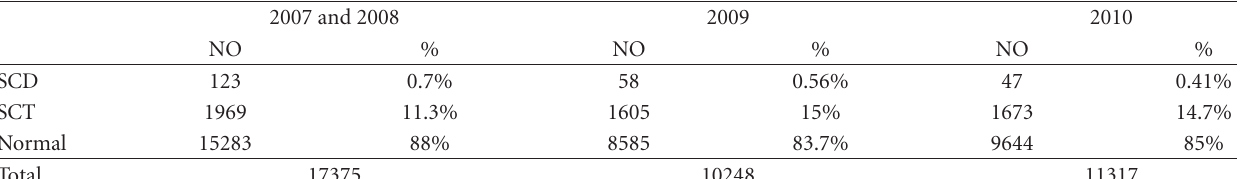
Table 2: A ff ected newborns with sickle cell disease per year during 2007 to 2010.